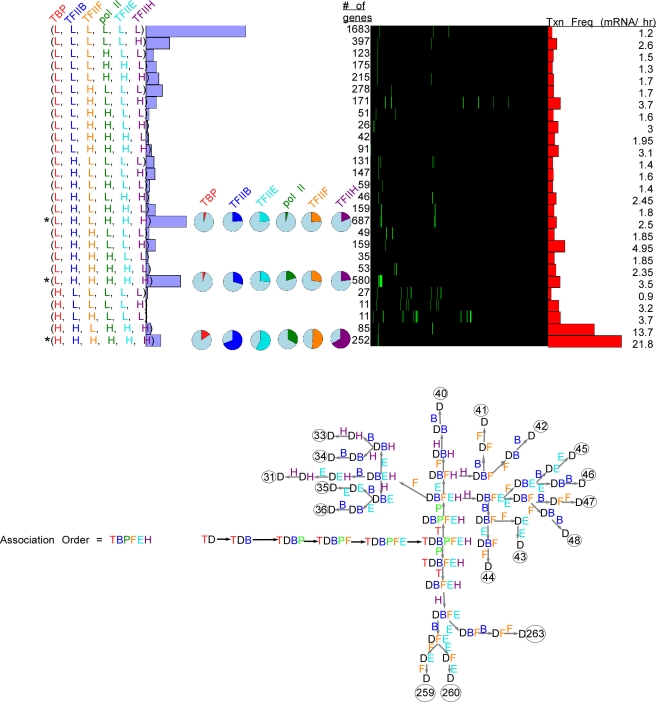
Six factor (TBP, TFIIB, Pol II, TFIIF, TFIIE, and TFIIH) modeling of genome-wide ChIP occupancy data using the assembly pathway TBP → TFIIB → pol II→ TFIIF → TFIIE → TFIIH.See Figures 1 and 2 for panel descriptions.